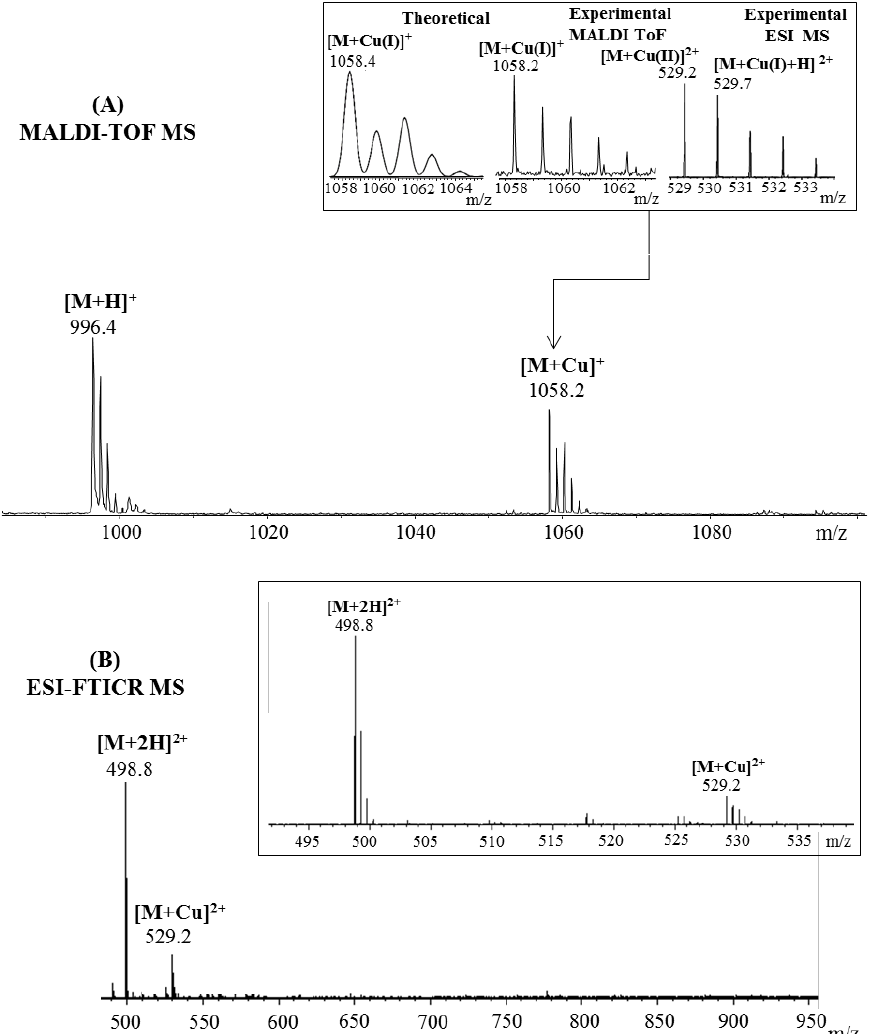
Figure 4. Enlarged region of mass spectra of A β (9–16) peptide incubated with Cu 2+ ions acquired by ( A ) MALDI ToF (reflectron mode) with CHCA matrix and ( B ) ESI-FTICR, both in positive mode. Inserts: ( A ) details of theoretical and experimental isotopic patterns of [M + Cu] + ion; ( B ) detail of the double-positive-charged peptide